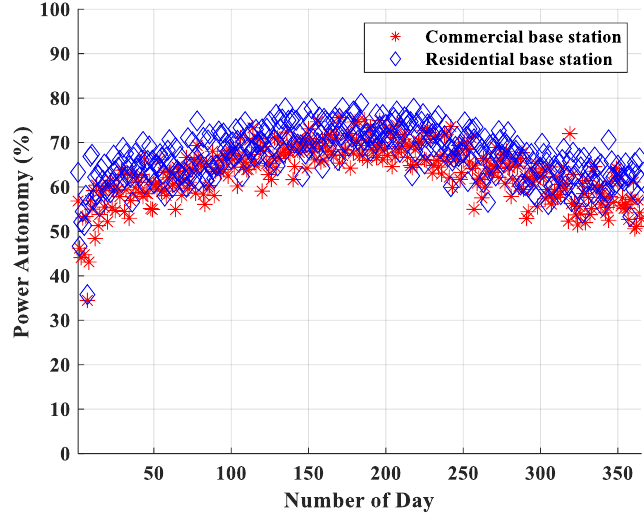
Figure 15. Power autonomy factor for Malaga throughout the year.